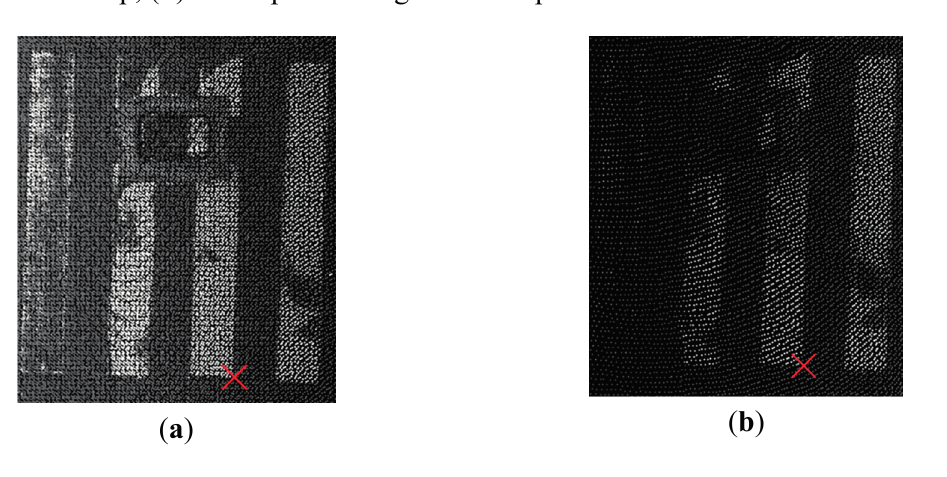
Figure 9. Error vectors of check points before and after